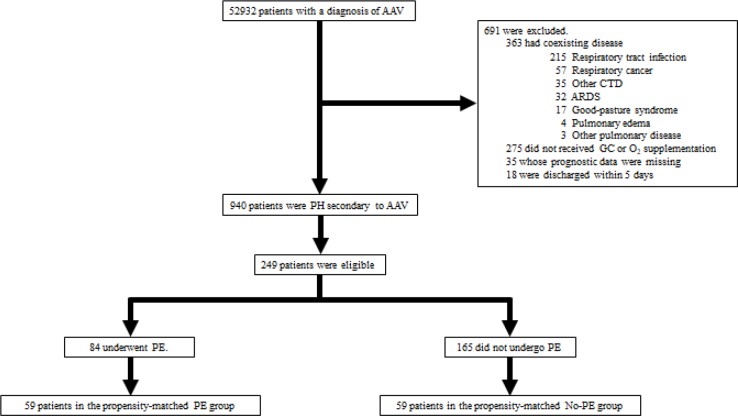
Patient selection flowchart.The patient selection procedure is depicted. AAV, antineutrophil cytoplasmic antibody-associated vasculitis; PH, pulmonary hemorrhage; CTD, connective tissue disease; GC, glucocorticoid; O2, oxygen; PE, plasma exchange.